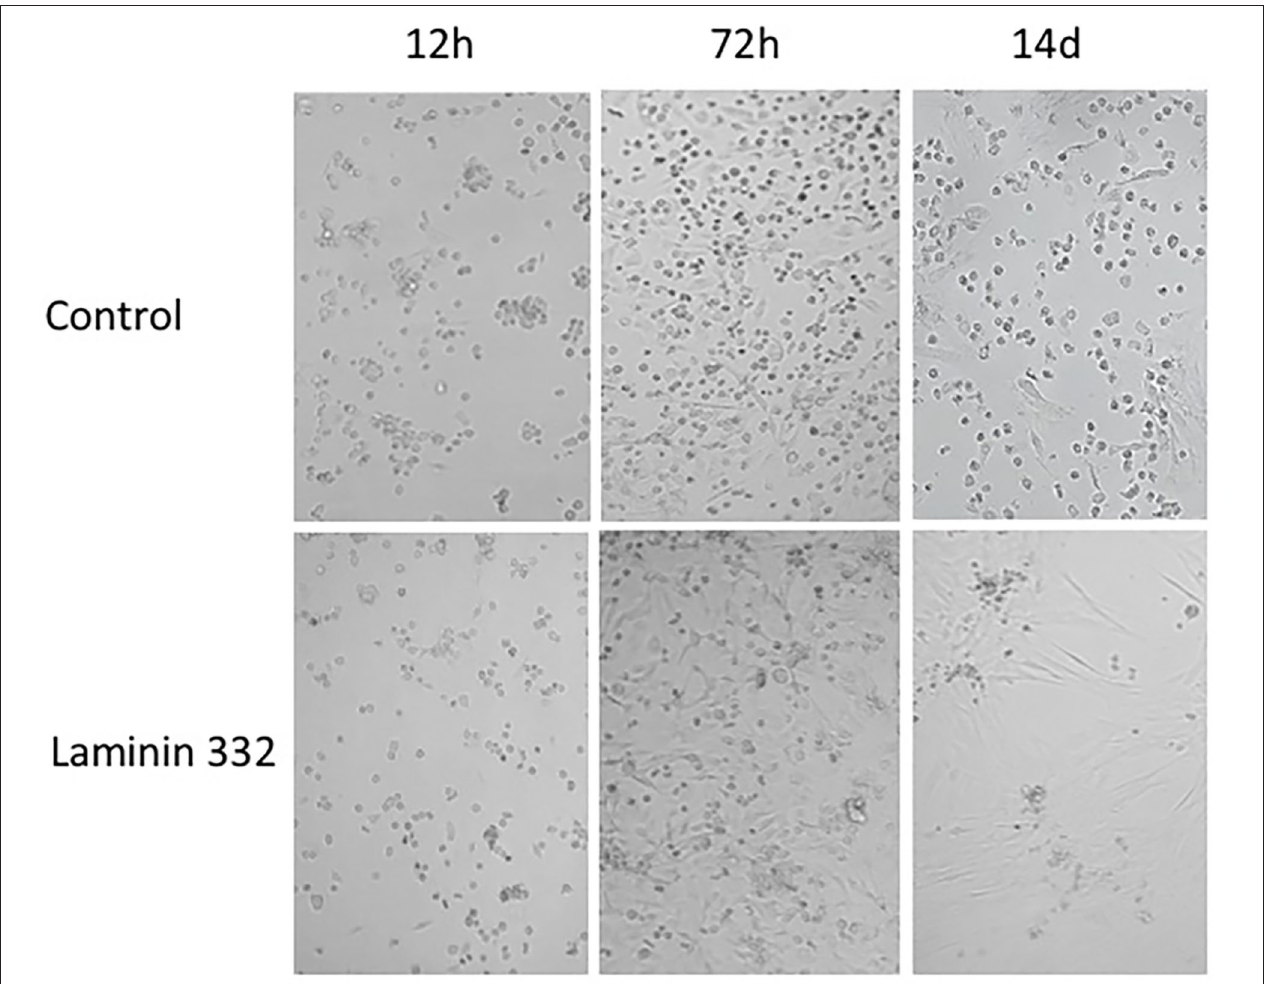
FIGURE 2 | Morphology of hAC cells cultured 14 days on uncoated and laminin-coated plates. Different proportions of adherent and non-adherent cells after 12, 72h, and 14 days of culture can be seen (Magn. 100 x